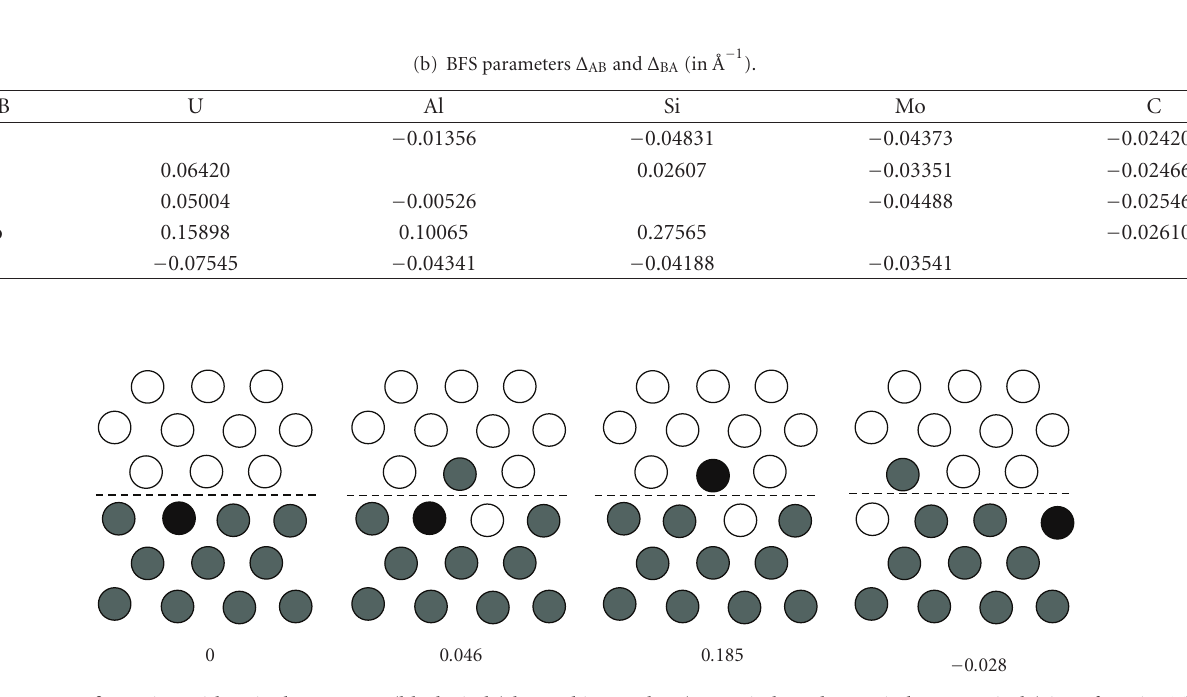
Figure 2: Configuration with a single Mo atom (black circle) located in an Al/U (open circle and grey circle, respectively) interface site. The di ff erence in energy (in eV) with respect to the reference state (left panel) is shown for each case.